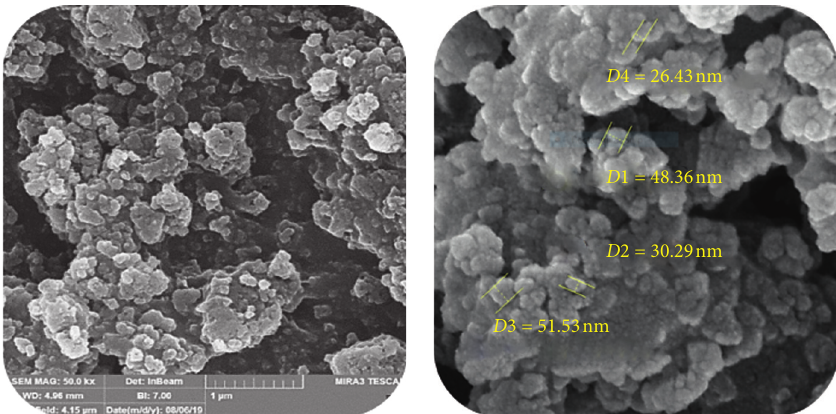
Figure 6: SEM image of the biosynthesized CuNPs by using pistachio hull extract.